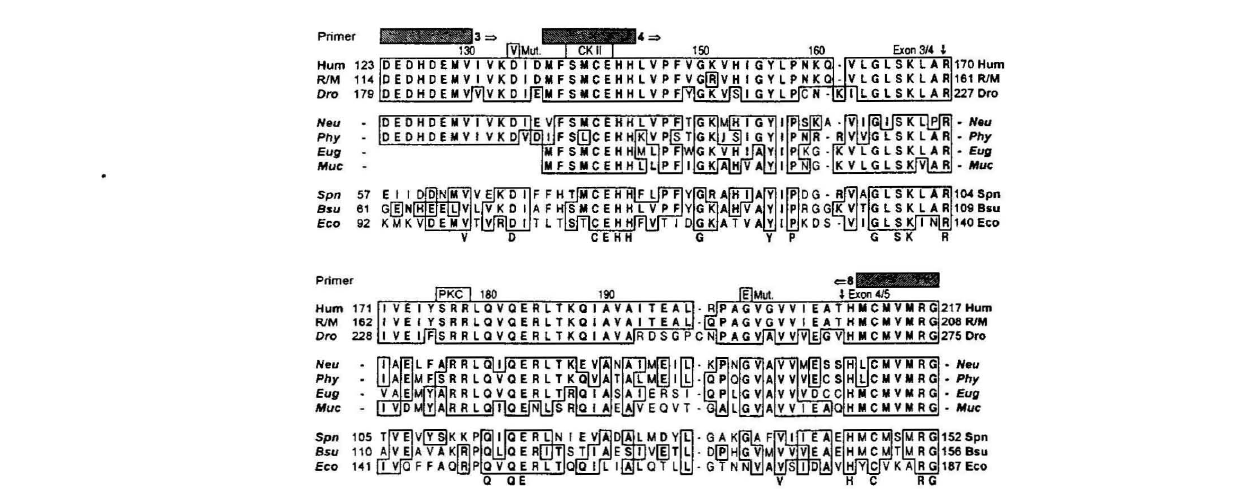
Figure 1. Comparison of known GTP-cyclohydrolase I amino acid sequences with the RT-PCR products produced with primers 3 + 8 or 4+ 8. Identical amino acids are boxed. Conserved amino acid substitutions are printed in bold letters. Th~ numbering is according to the rat sequence (II). Hum, human sequence (8. 9, 10); M/R, mouse/rat (11, 12); Dro, Drosophila melanogaster (13); Neu, Neurospora crassa; Phy, Phycomyces blakesleeanus; Eug. Euglena gracilis; Muc, Mucuna hassjoo; Spn, Streptococcus pneumoniae (16); Bsu, Bacillus subtilis (15); Eco, Escherichia coli (14). Positions, where human mutations were detected (Mut.) (19) and splice junctions of Drosophila exons (13) are shown and marked by arrows.